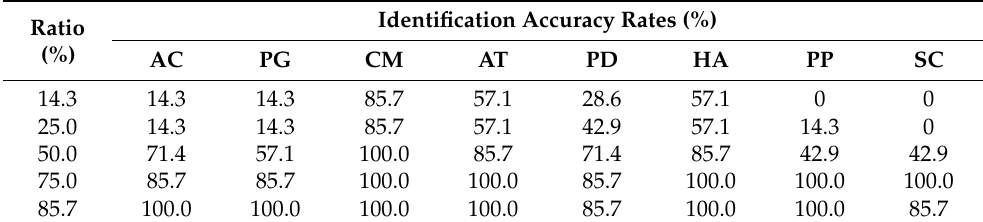
Figure 5. Confusion matrix of eight species of tested algal samples. Table 6. Results of identification in mixed samples according to new